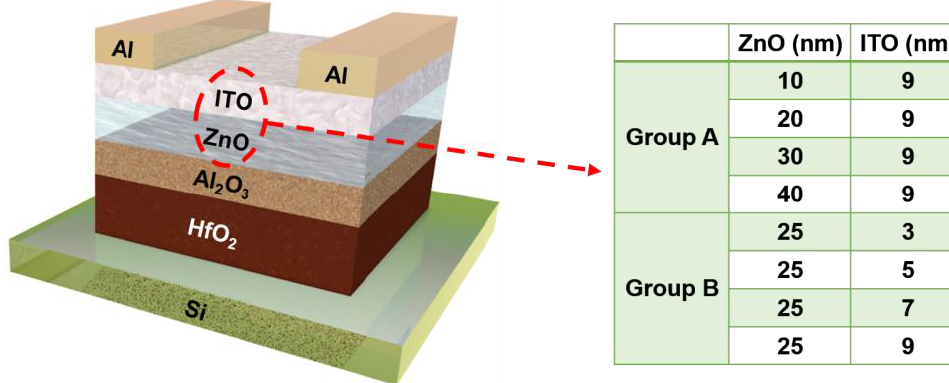
Figure 1. Schematic of the ZnO/ITO TFTs used in this article.